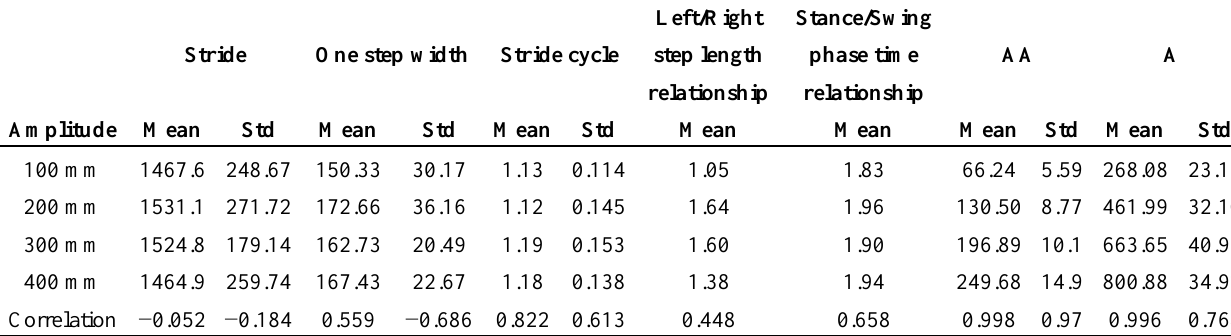
Table 4. Gait parameters obtained following a sinusoidal path (one